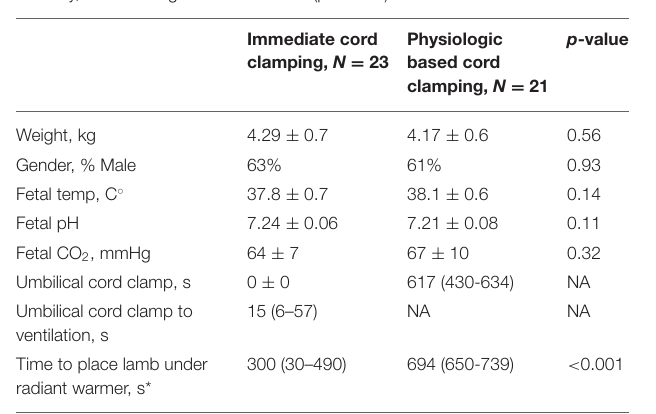
TABLE 1 | Baseline characteristics presented in mean and standard deviation or median and interquartile range (25 to 75%), kg, kilograms; temp, temperature; s, seconds; C ◦ , degrees Celsius; CO 2 , carbon dioxide; mmHg, millimeters of mercury, *denotes significant difference (p < 0.05).